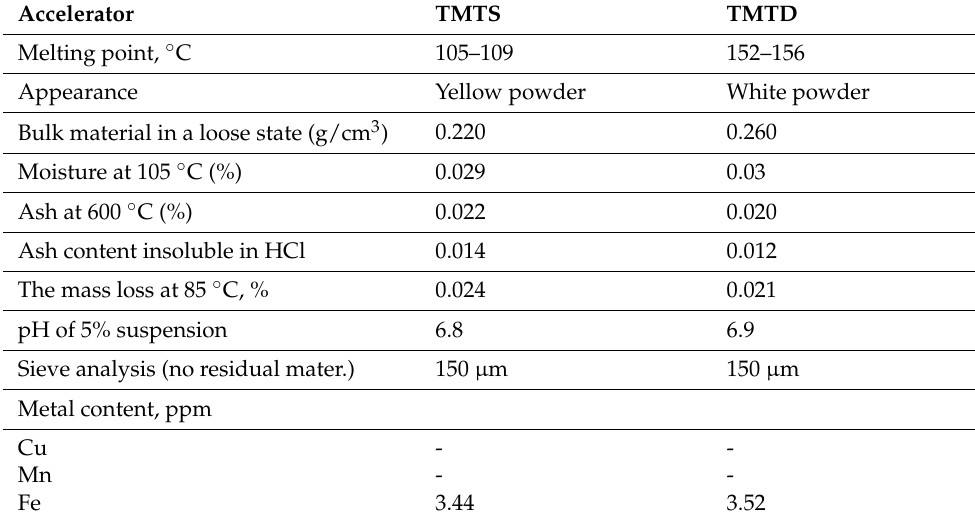
Table 7. The physico-mechanical characteristics of the accelerators TMTS and